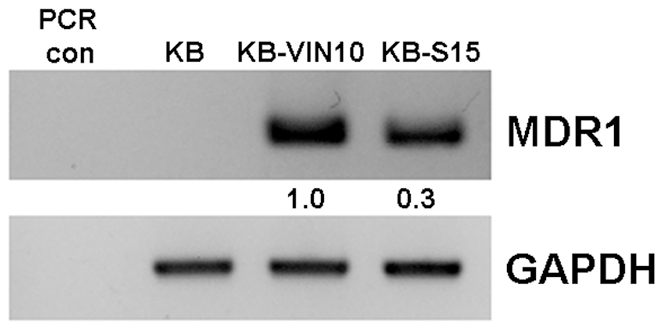
Level of MDR1 expression correlates to the level of resistance of VX680/PHA739358 in KB-VIN10 and KB-S15 cancer cells.Total mRNA was extracted from cells, and RT-PCR was performed to detect the expression of MDR1 in KB, KB-VIN10 and KB-S15 cells. GAPDH was used as internal control.